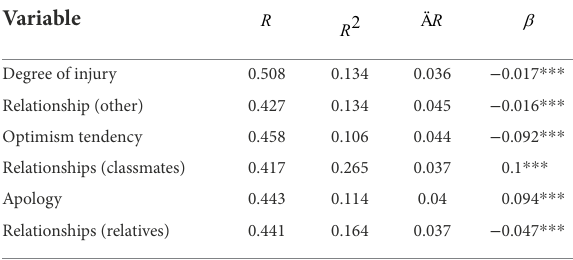
TABLE 2 Stepwise multiple regression analysis of college students’